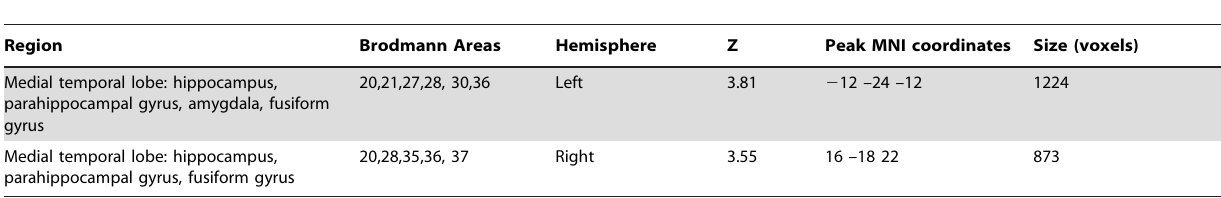
Table 2. Regions displaying a reduced BOLD signal relative to baseline during the Primed condition but not during the WM condition. (Experiment